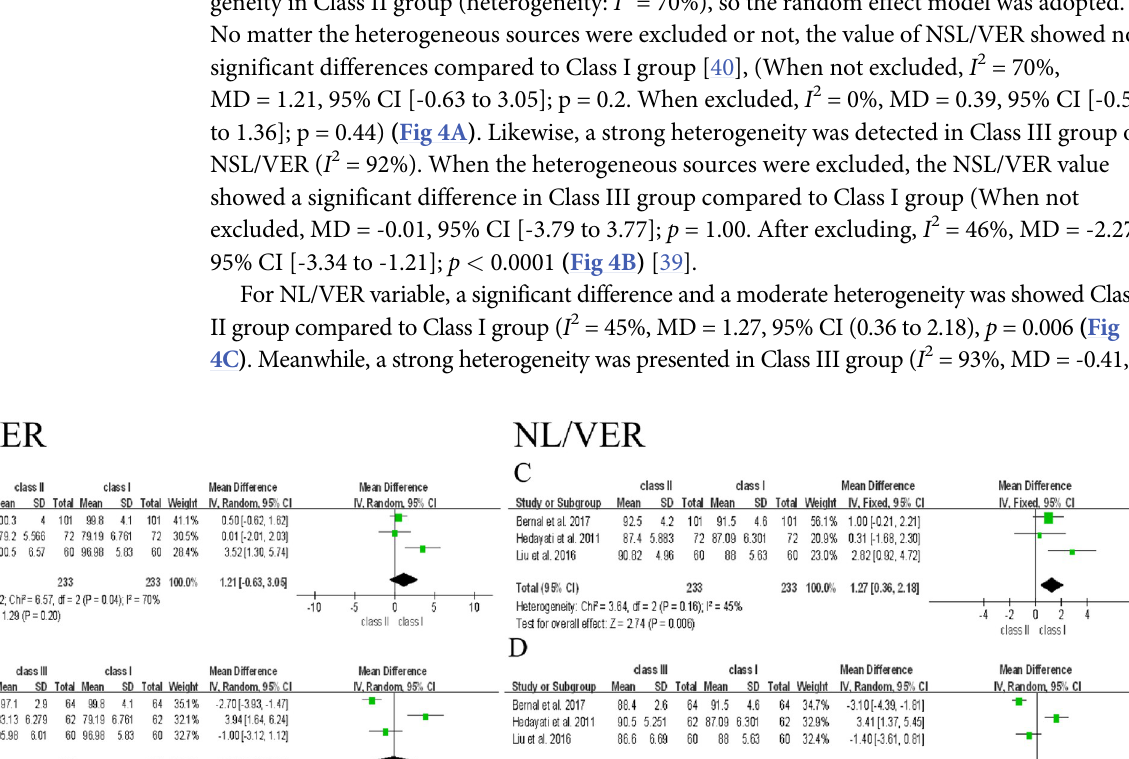
PLOS ONE | https://doi.org/10.1371/journal.pone.0276156 October 25,